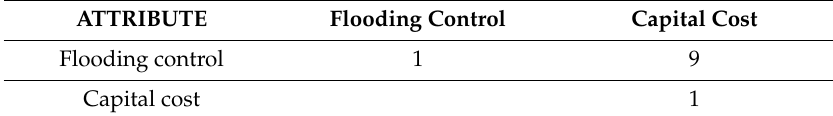
Table A6. Writing example (flooding control is of extreme importance than capital